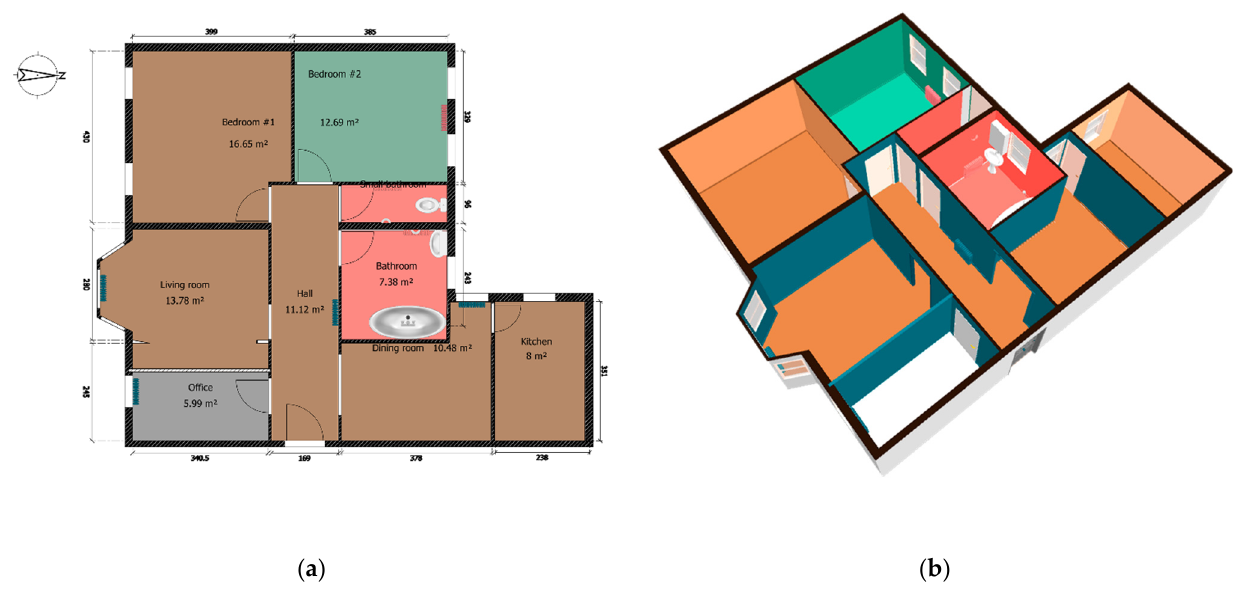
Figure 11. Initial ( a ) 2D and ( b ) 3D plan of the apartment.